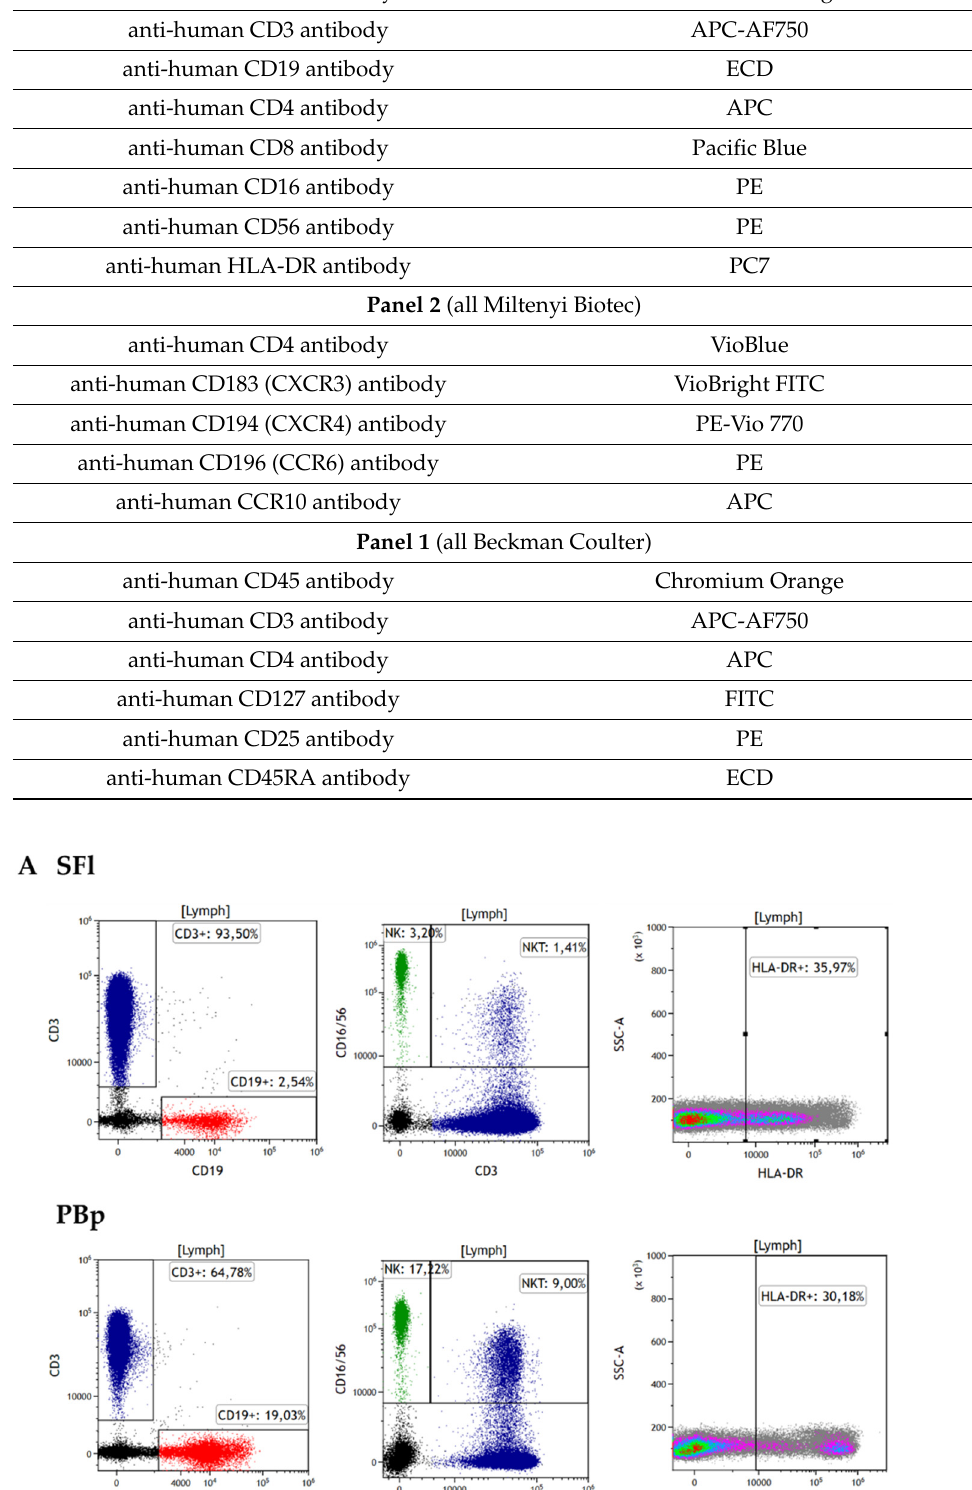
Figure 2. Lymphocyte composition of SFl and PBp/c by flow cytometry analysis. ( A ) Gating strategy of lymphocyte subpopulations in SFl and PBp after staining with panel 1; CD3+ T cells are depicted in blue, CD19+ B cells are shown in red, and NK cells in green. ( B ) Percentage of lymphocytes for CD3+ T cells, CD19+ B cells, and CD56/16+ CD3- NK cells. ( C ) Percentage of lymphocytes for CD56/16+ CD3+ NKT cells and activated lymphocytes (HLA-DR+); * p < 0.05, ** p < 0.01, *** p < 0.001, **** p < 0.0001.